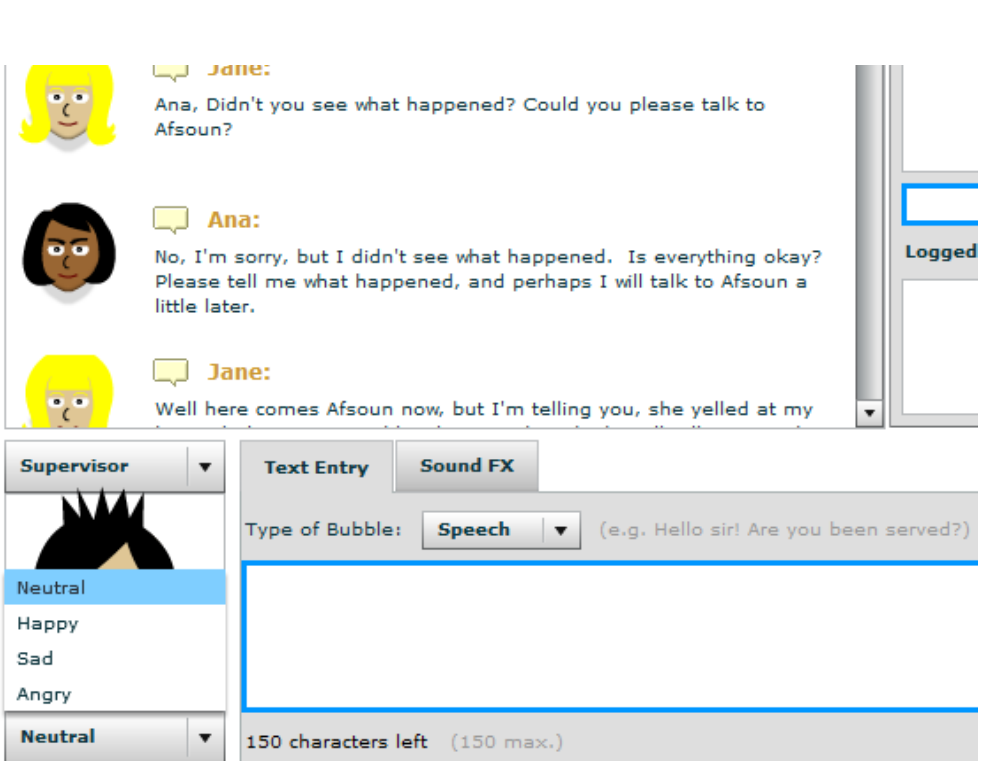
Figure 4 . Screenshot of the Lake Devo Emotional Expression Selector